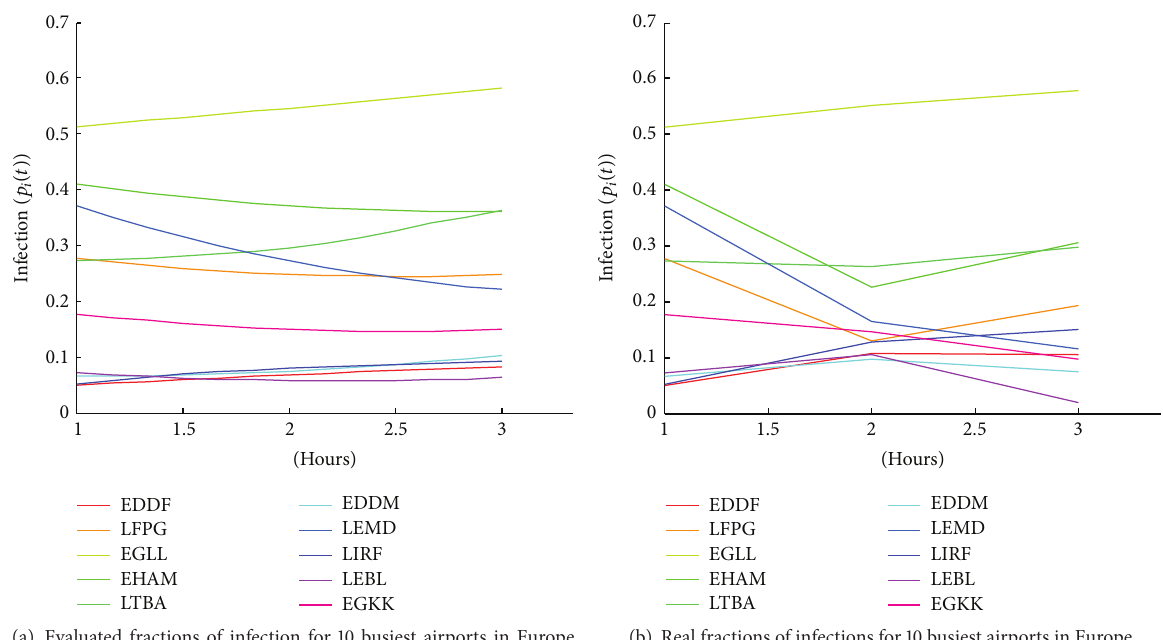
Figure 9: Comparison between the results of the airport-based epidemic model and real data on June 02, 2015.